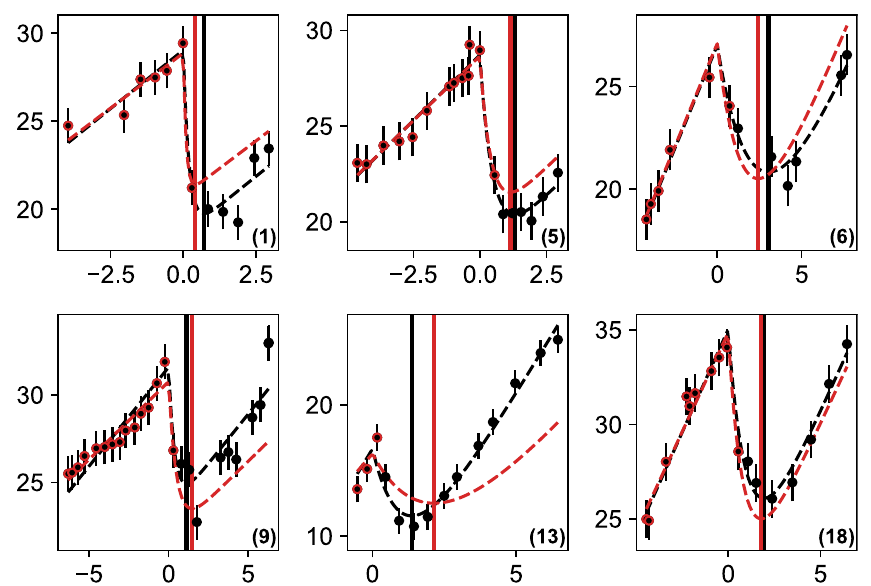
Fig 5. Predictions for the regrowth time on real data with the first point after RT. The black dashed curve shows the best fit model using all the data points and the vertical black line shows its minimum (same as Fig 2). We then only consider the red circled points consisting of all the points before RT and the first one just after, and perform the constrained minimization described in the text. The result for the model is the dashed red curve with the estimated regrowth time shown as the vertical red